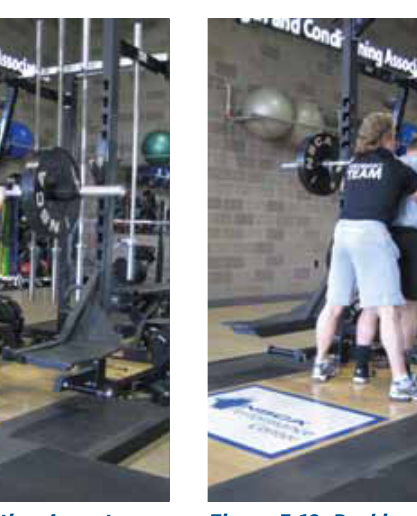
Figure 3-16. Ascending Figure 3-17. Spotter Assisting Ascent Figure 3-18. Racking the